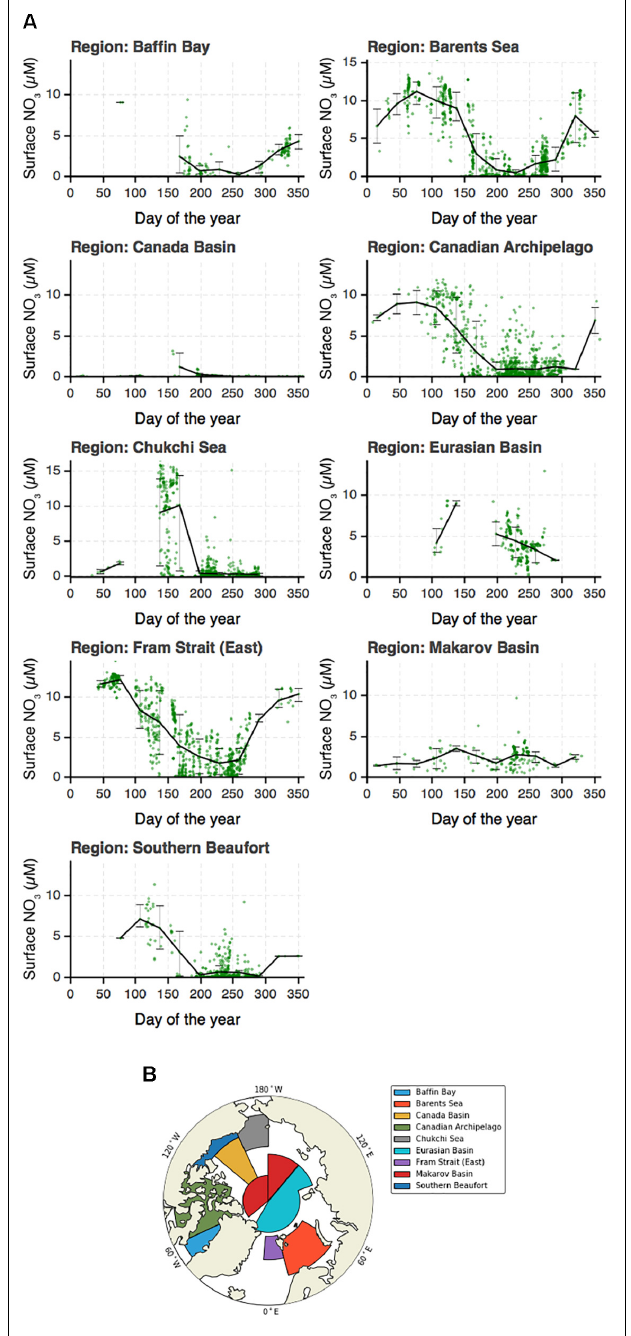
FIGURE 1 | (A) Seasonal cycles of surface nitrate concentrations in different regions of the Arctic. (B) The delineation of these regions largely follows Codispoti et al. (2013) and Peralta-Ferriz and Woodgate (2015).